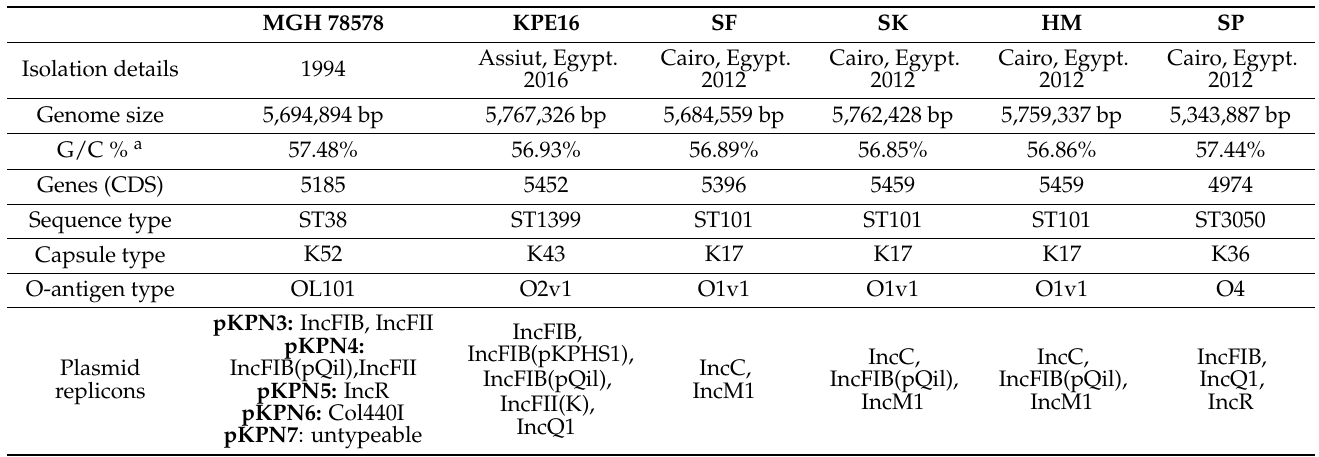
Table 2. Genome analysis of Klebsiella pneumoniae strains isolated in